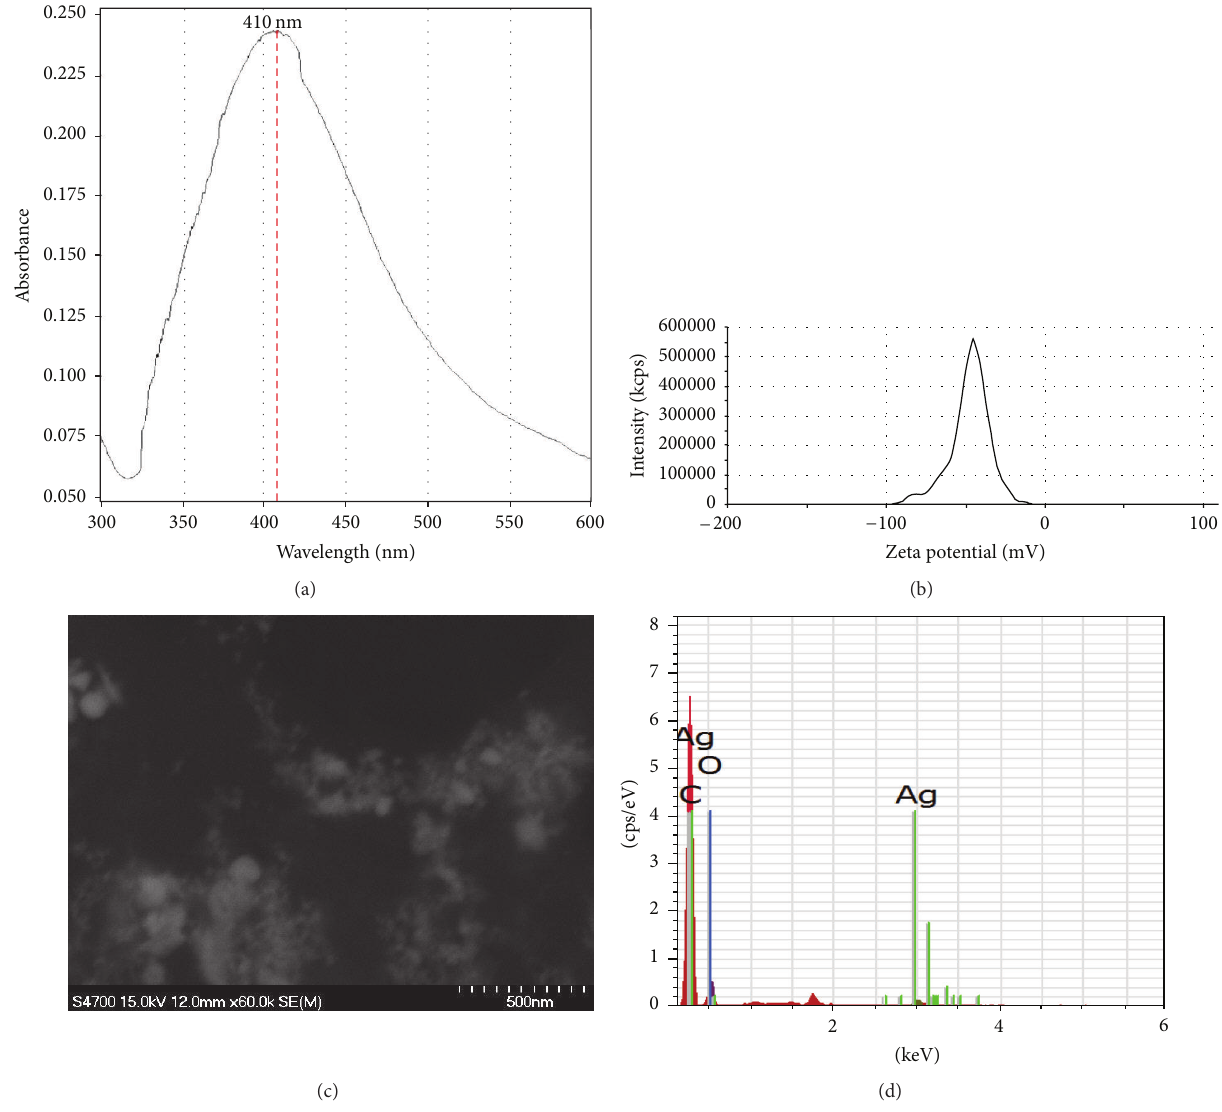
Figure 3: Nanosilver colloid (a) UV-Vis analysis, (b) Zetasizer analysis, (c) SEM image, and (d) EDX component analysis.